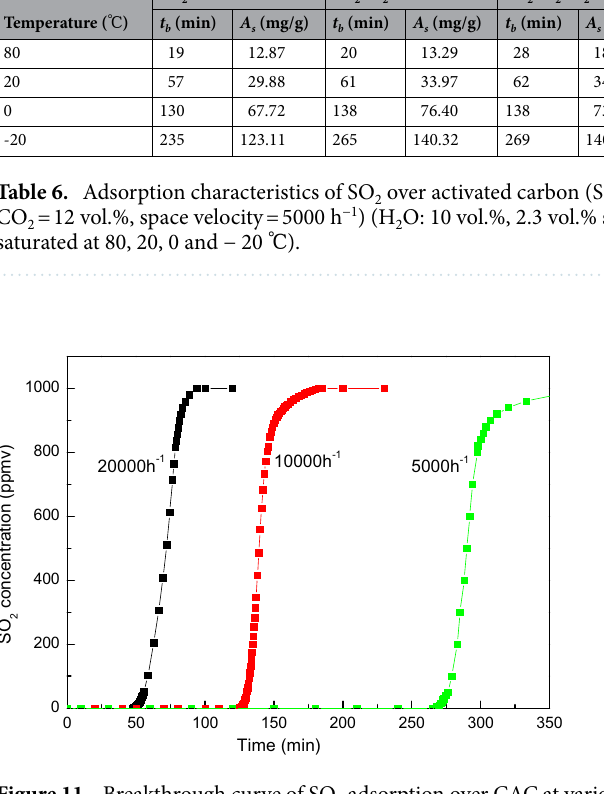
Figure 11. Breakthrough curve of SO 2 adsorption over CAC at various space velocity (SO 2 = 1000 ppmv, O 2 = 6 vol.%, T = − 20 ℃ , flow rate = 1 L/min).